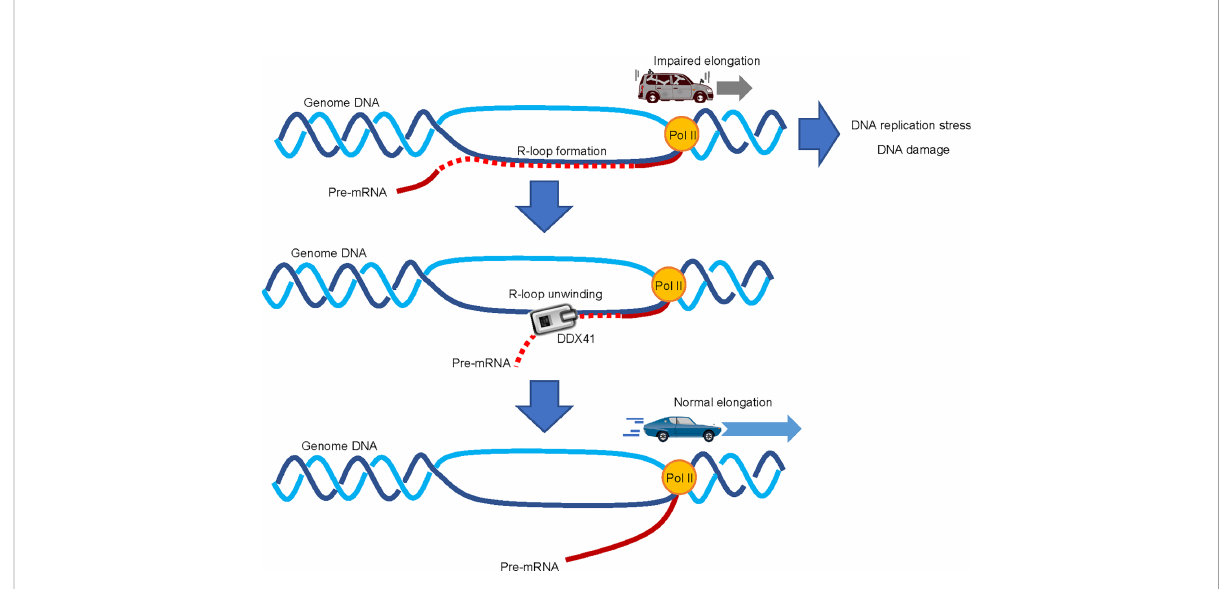
FIGURE 4 Involvement of DDX41 in R-loop resolution. Abnormal accumulation of R-loops impairs transcriptional elongation by RNA polymerase II (Pol II), which leads to increased replication stress and DNA damage; DDX41 has been proposed to directly unwind DNA : RNA hybrids to resolve